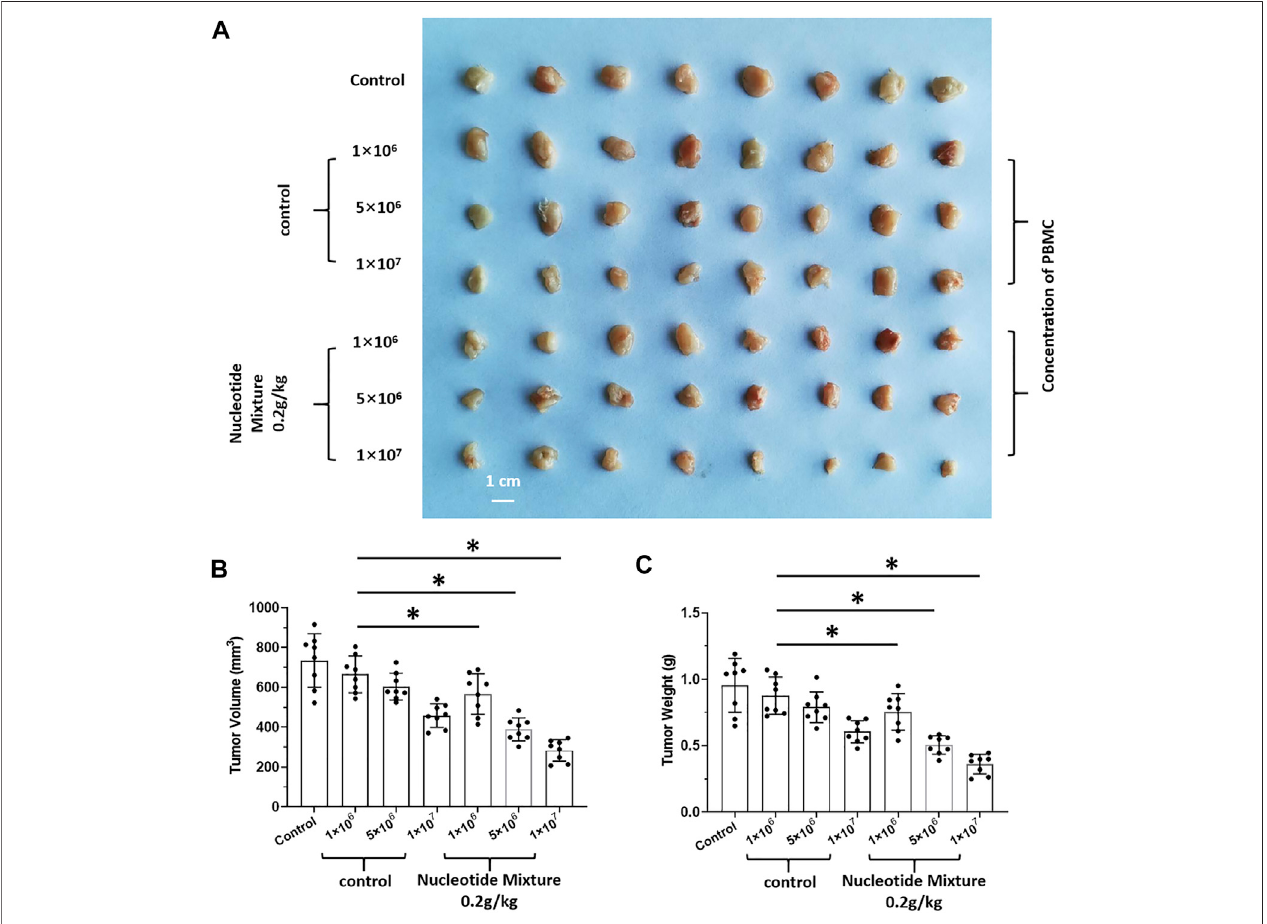
FIGURE 7 | Combined infusion of nucleotide mixture and healthy human peripheral blood lymphocytes on tumorigenesis of human HCC MHCC97-H in immunode fi cient mice. MHCC97-H cells were obtained by culture. After MHCC97-H cells had been inoculated subcutaneously into SCID mice, peripheral-blood lymphocytes were isolated from human volunteers. SCID mice were inoculated with 1 × 10 6 , 5 × 10 6 , or 1 × 10 7 cells each time/mouse (once every 2 days, 10 times in total). During injection of peripheral-blood lymphocytes, mice received the control or SNM (0.2 g/kg) every day. After treatment, tumor tissue was collected and photographed (A) . Photographs of subcutaneous tumor tissue (A) , tumor volume (B) , and tumor weight (C) . * p <